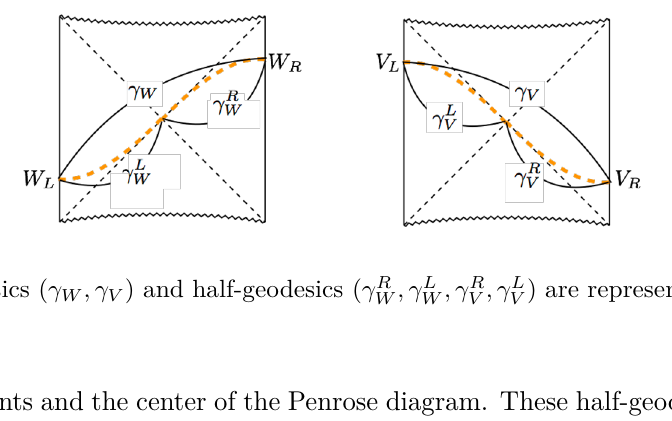
, and the right one is at x = x . Straight lines are the W V ) and bulk points L , W R , V L , V R ) that are represented dashed curves. , γ L W V